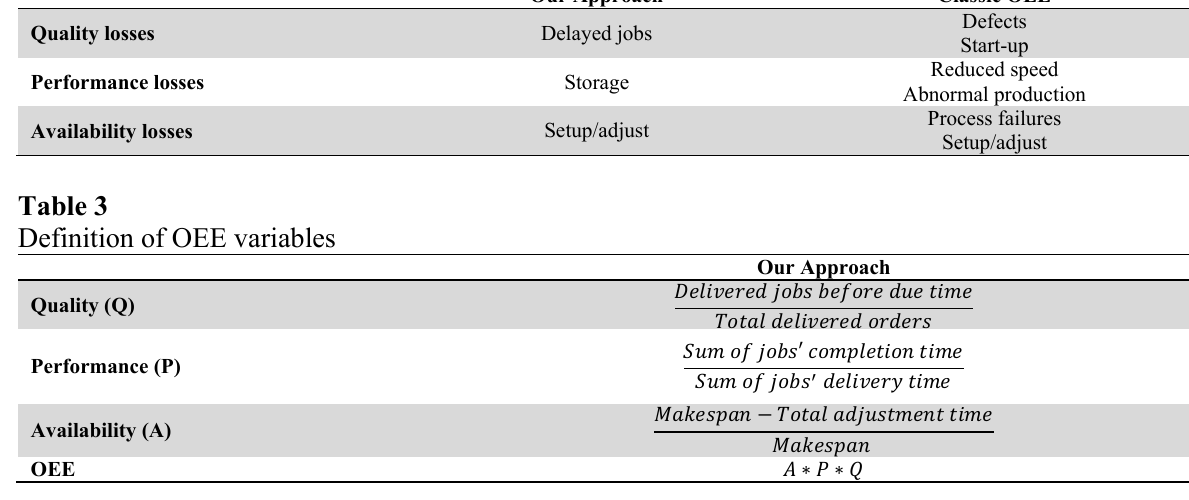
Definitions of OEE concepts